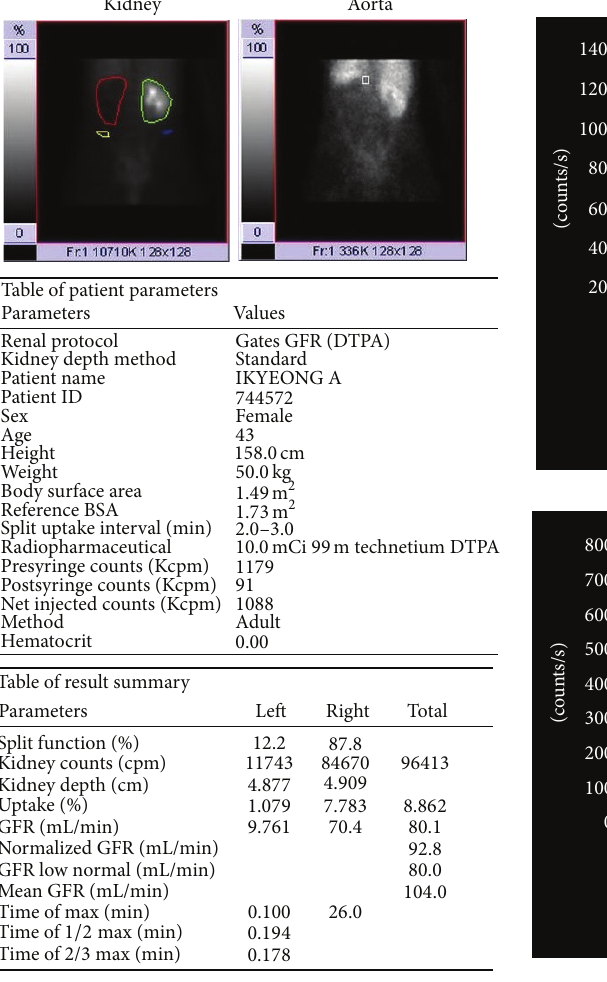
Figure 2: Renal scintigraphy. Complete loss of function of the left